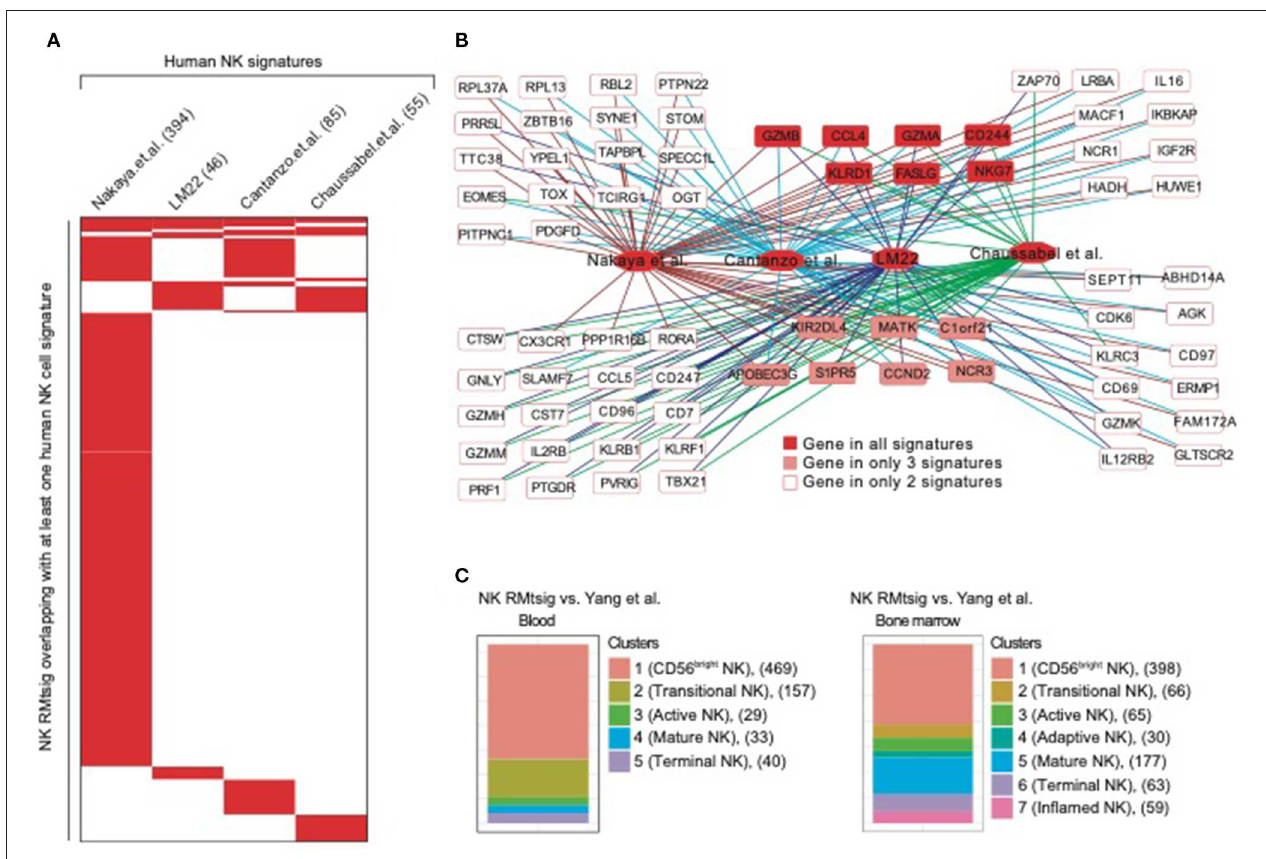
FIGURE 2 | NK cell signature from NHP overlaps with published NK signatures in humans. (A) Heatmap showing the overlap between NK RMtsig and published NK signatures from several human studies. Each column represents an NK signature from humans and each row represents a common gene with the NK RMtsig, depicted in red if the gene is present in the human signature or in white if the gene is absent from the human signature. For each human signature, the number of overlapping genes with the NK RMtsig is shown between parentheses. (B) Genes Network of NK genes common to both NHP and humans from the signatures shown in panel A. (C) Graphical representation of the overlap between the NK RMtsig and NK cell populations signatures derived from human in blood and bone marrow using single cell RNA-Seq experiments.